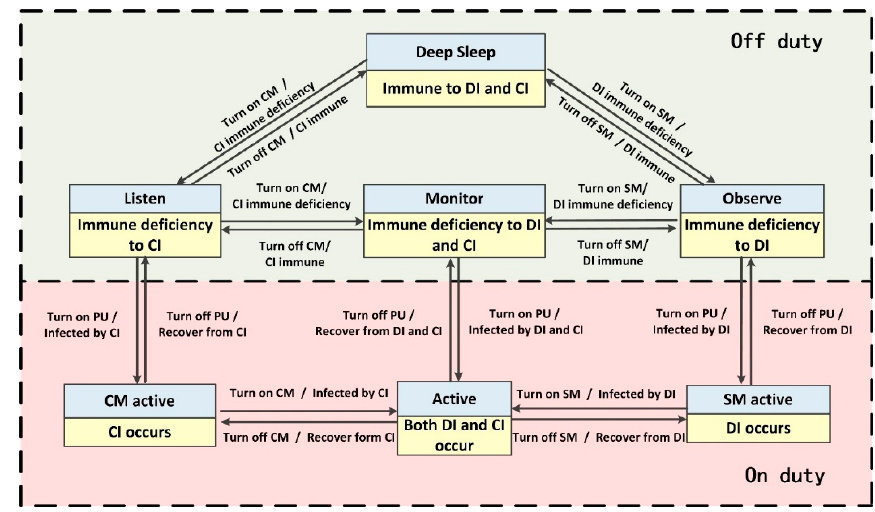
Figure 4. The corresponding relationships between the BDIIM and sensor wake-up control (WC) states. Table 3. The corresponding relationships between the WC states and sensor states.